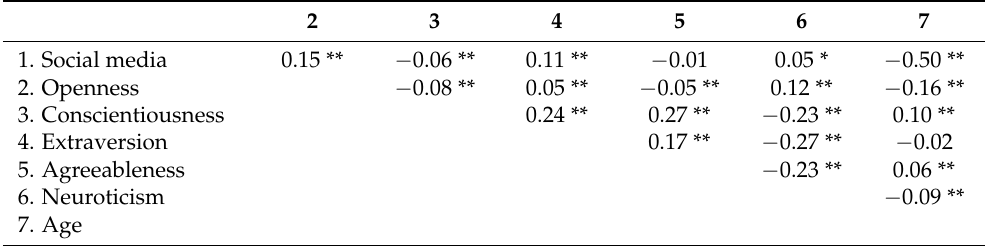
Table 3. Intercorrelations of study variables 1: social media usage, Big Five (BFI-10), age.